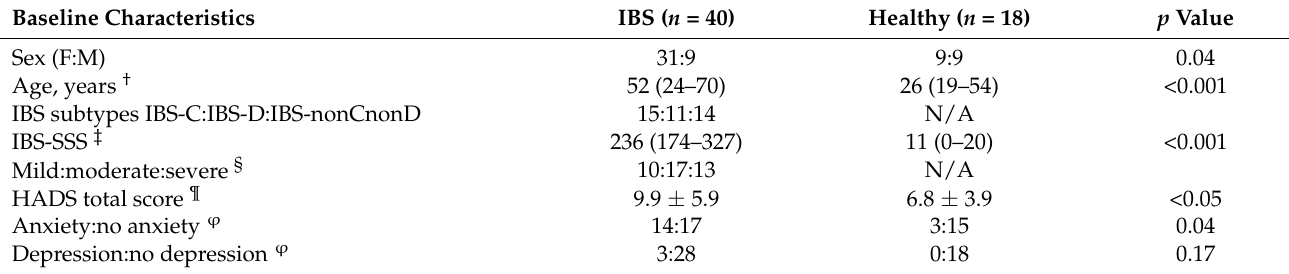
Table 1. Demographics and clinical characteristics of the study